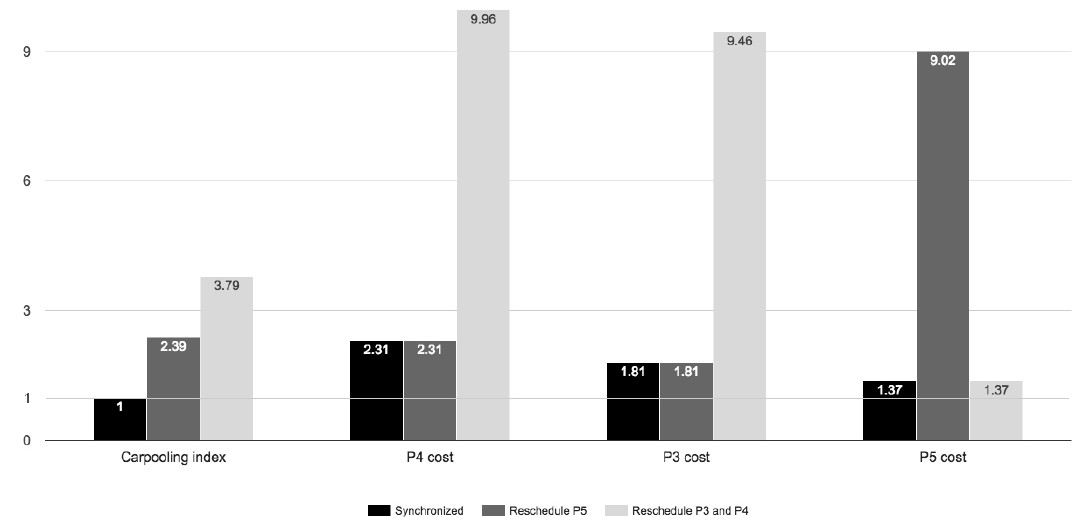
Figure 10. Carpooling index and individual user costs for different rescheduling options.